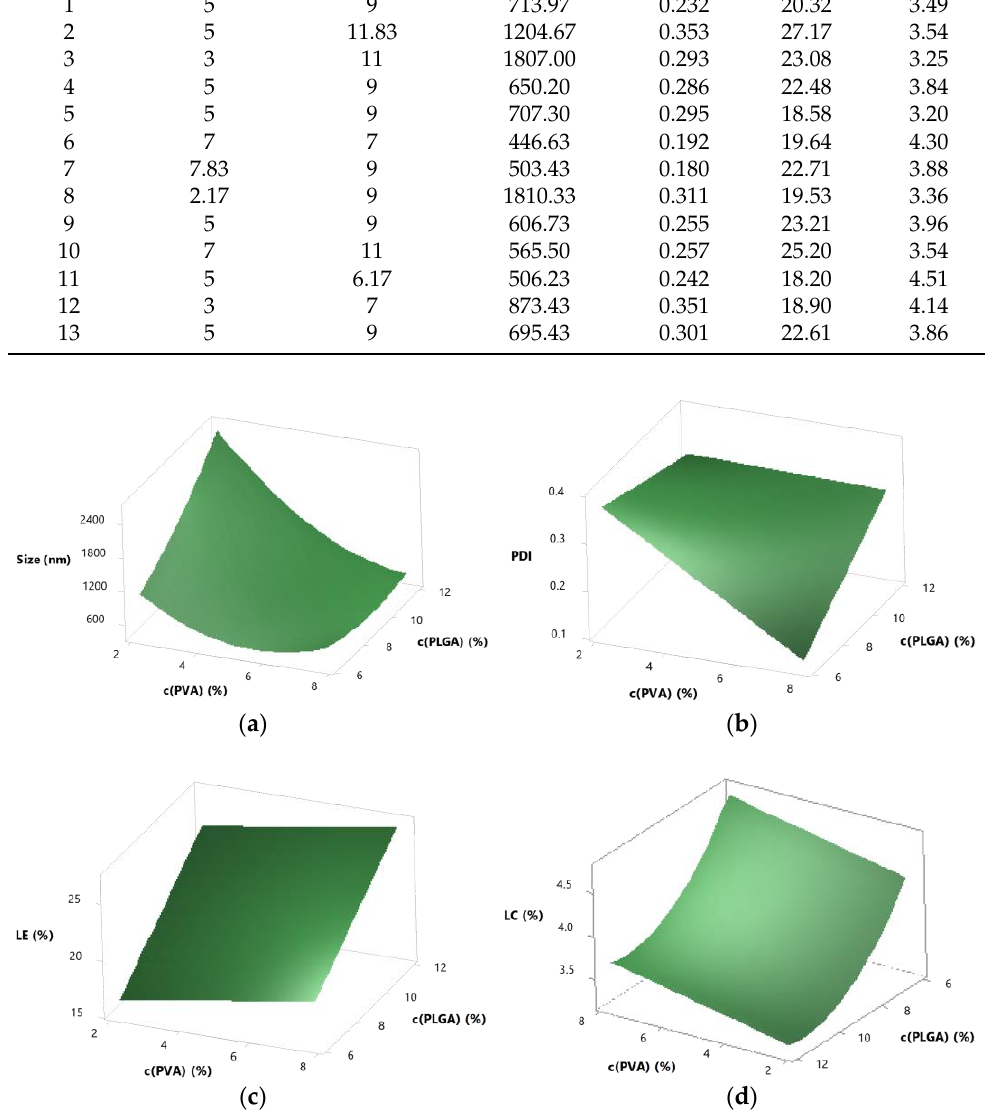
Figure 3. Response surface plots of z-average ( a ), PDI ( b ), LE ( c ) and LC ( d ), in dependence on PVA concentration in % and PLGA concentration in %.